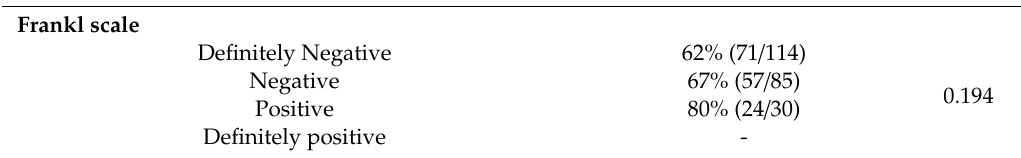
Plaque visible to the naked eye at the gingival margin 79% (80 /